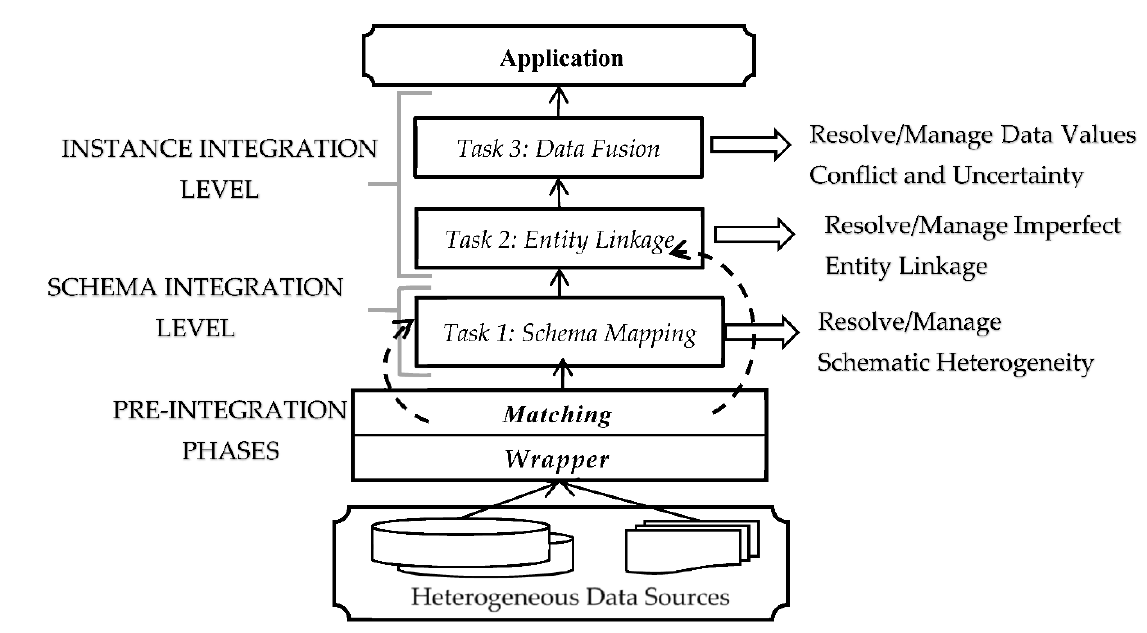
Figure 1. Data Integration level and its corresponding conflict resolution tasks.